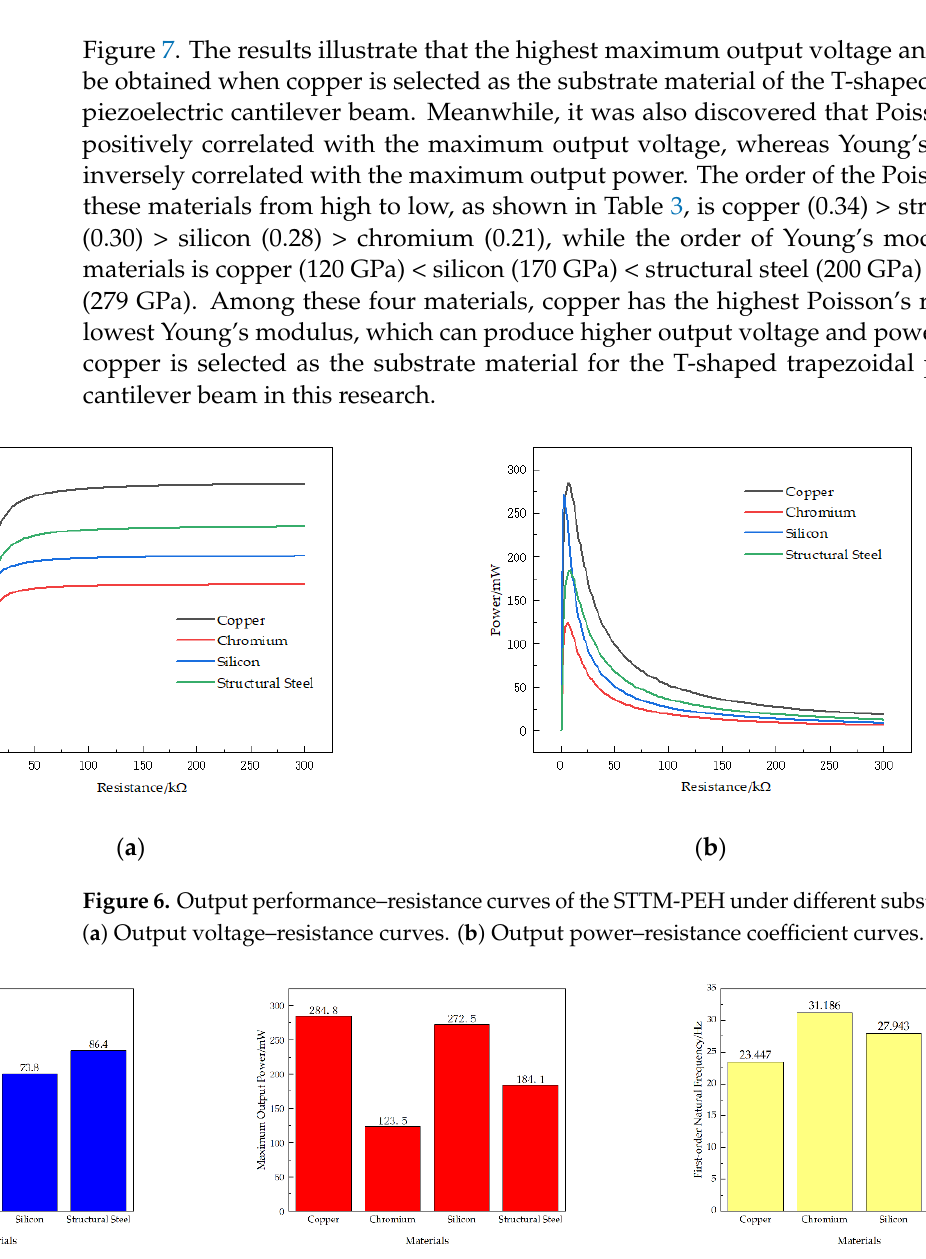
Figure 7. The results illustrate that the highest maximum output voltage and power can be obtained when copper is selected as the substrate material of the T-shaped trapezoidal positively correlated with the maximum output voltage, whereas Young’s modulus is